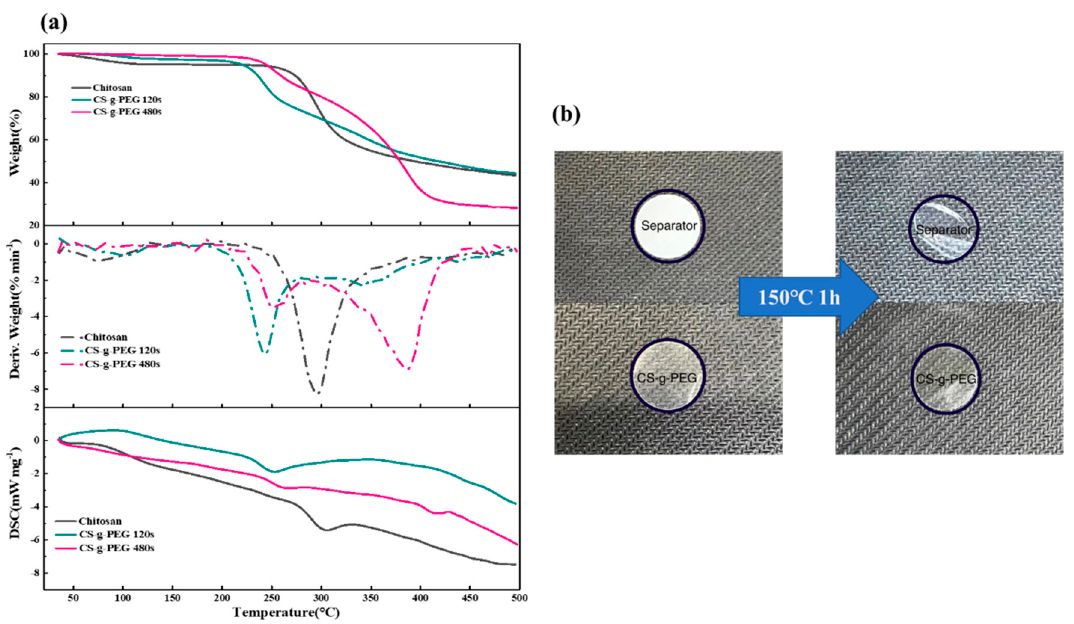
Figure 5. ( a ) Weight losses of films, the differential thermogravimetry (TG) curves and the differential scanning calorimetry (DSC) curves at temperatures from 25 to 600 ◦ C. ( b ) Images of commercial separator Celgard 2500 and CS-g-PEG that were kept at 150 ◦ C for 2 h.